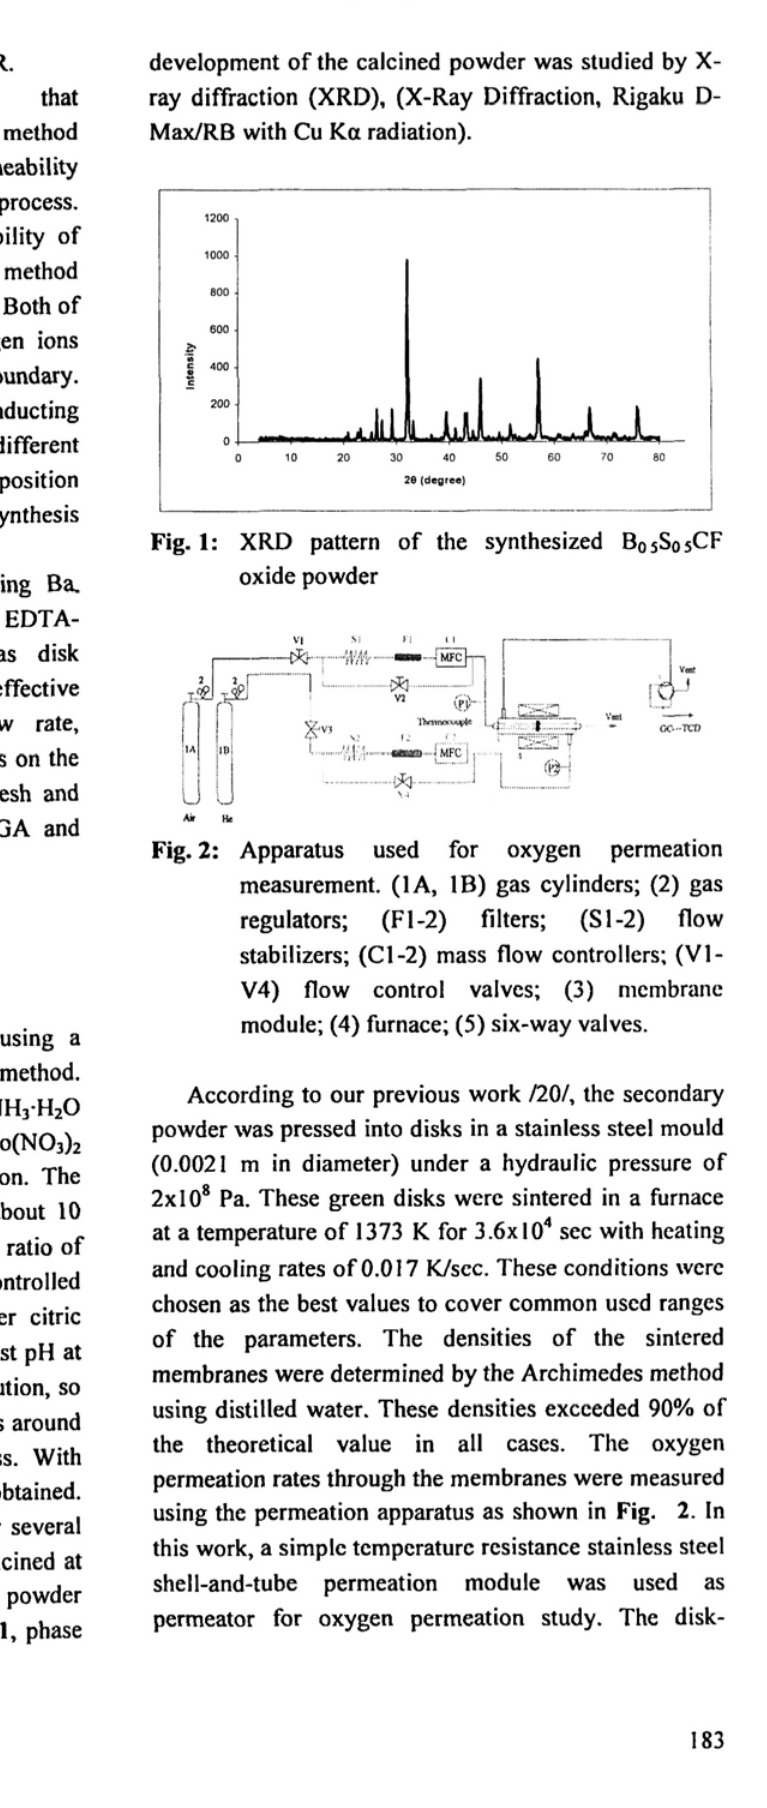
The densities of the sintered